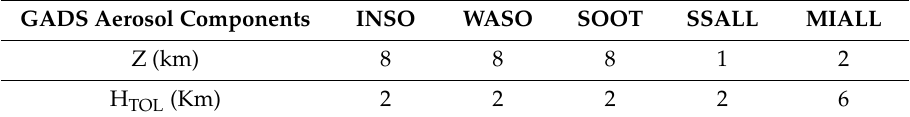
Table 4. Vertical structure of GADS aerosols as considered in SIRAMix.